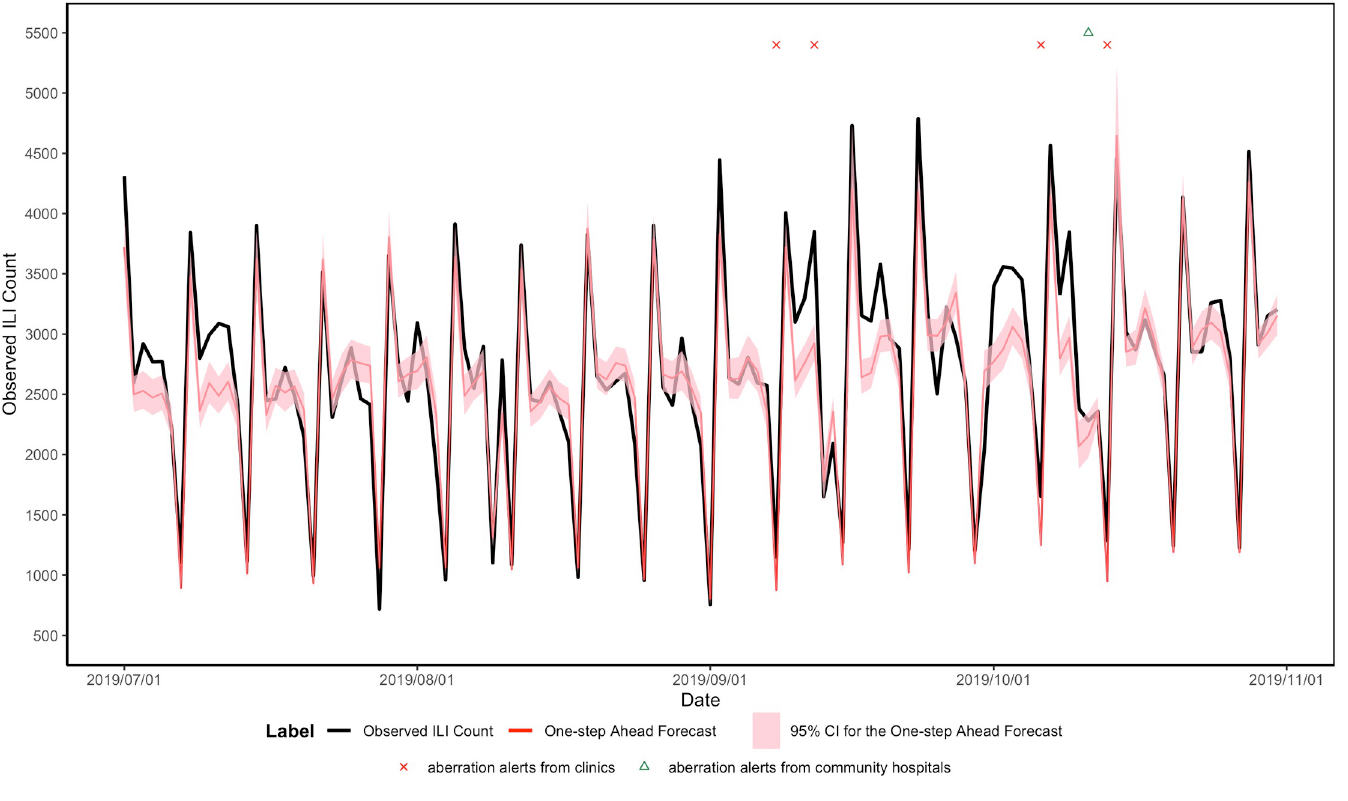
Fig 4. One-step-ahead forecasts for forecast period for ILI syndromes in a rolling manner.